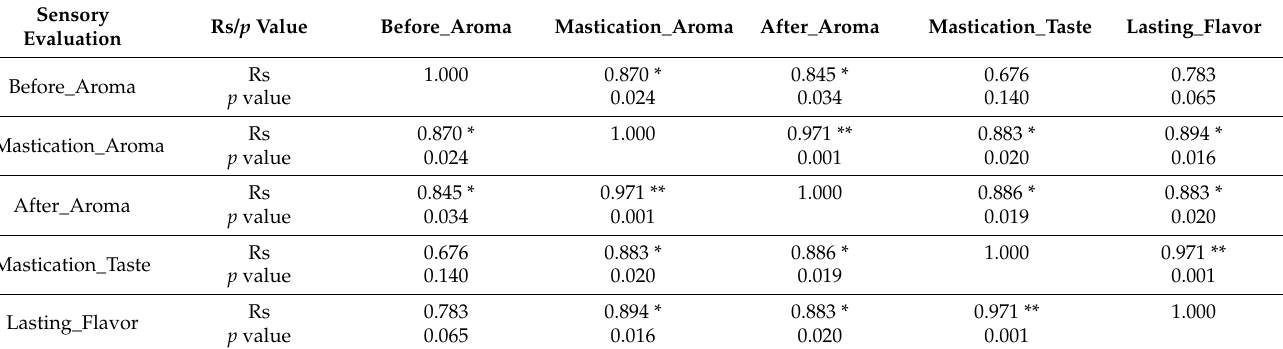
Table 2. Correlation coefficient among sensory scores